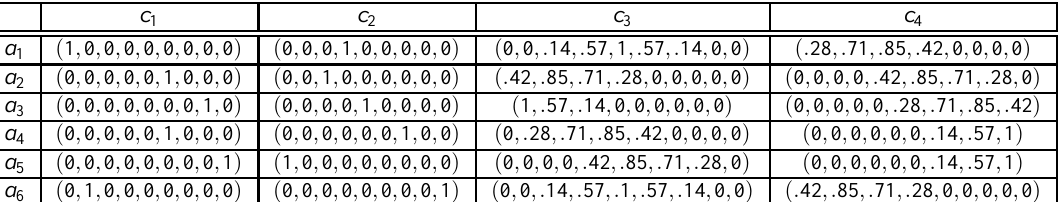
Table 2: Item database expressed into the BLTS